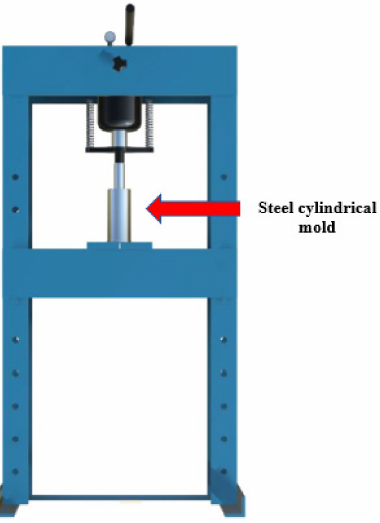
Figure 4. Layout of hydraulic press with steel mold used for briquette production. Reprint with permission [40]; Copyright 2021,